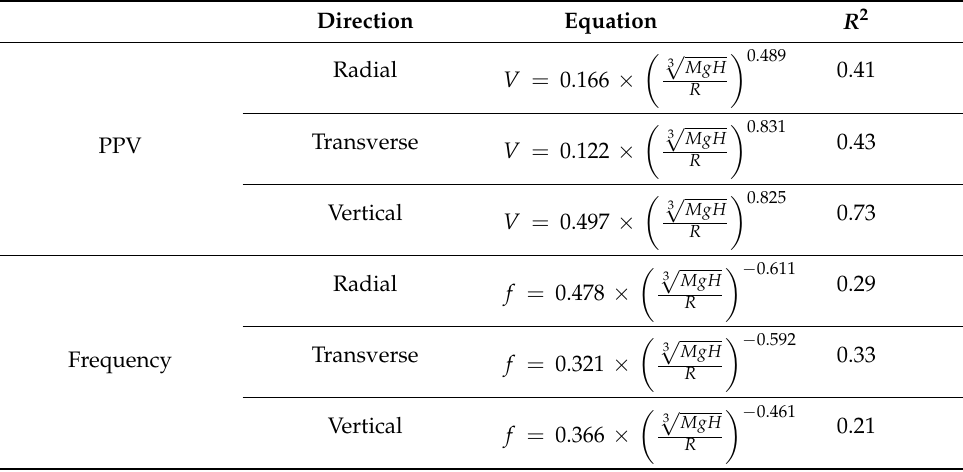
Table 3. Values of the constants computed by regression